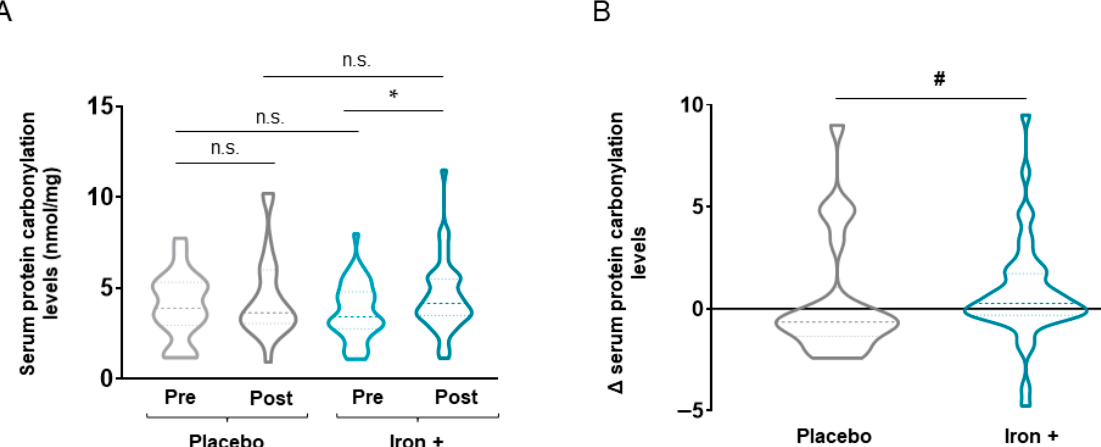
Figure 5. Violin plots of absolute protein carbonylation levels in serum of all COPD patient groups ( A ) and delta (post-pre) of serum protein carbonylation levels in placebo and iron-treated groups ( B ). The dashed line represents the median and the dotted lines the interquartile ranges. Statistical significance: n.s., no significance; * p < 0.05 between post-iron and pre-iron treatment; # p < 0.05between iron and placebo treatments.